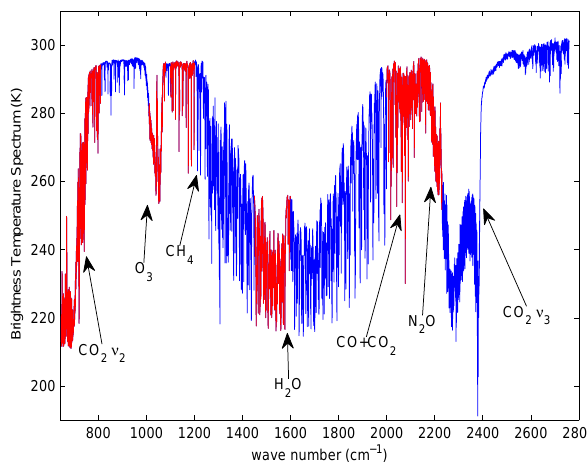
Fig. 10. The IASI spectral coverage and the spectral intervals (in red) used for the inversions of skin temperature, temperature, water vapour and ozone profiles.